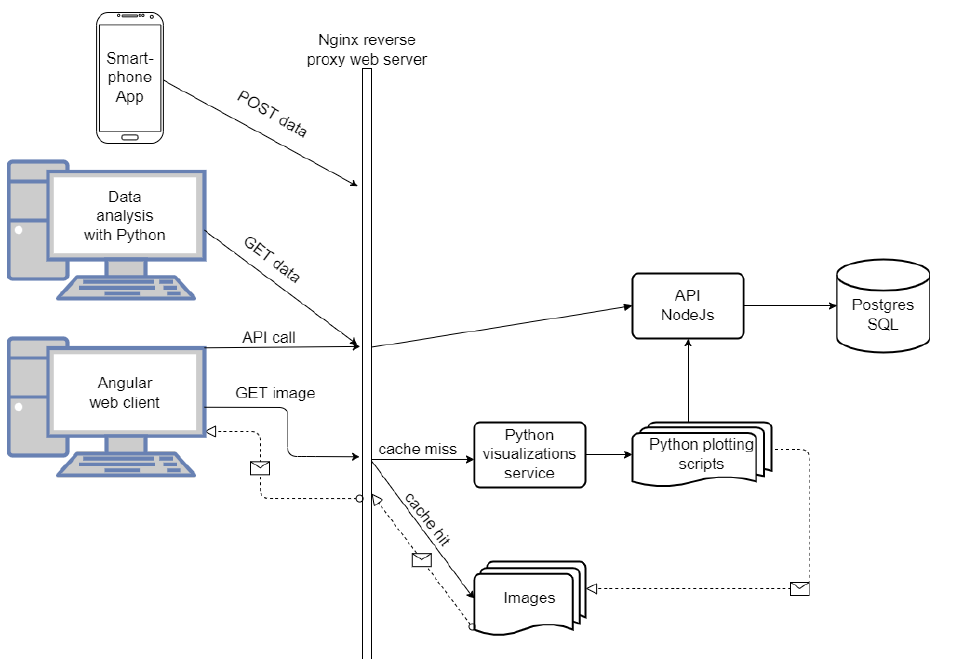
Figure 2. System architecture of testing environment.